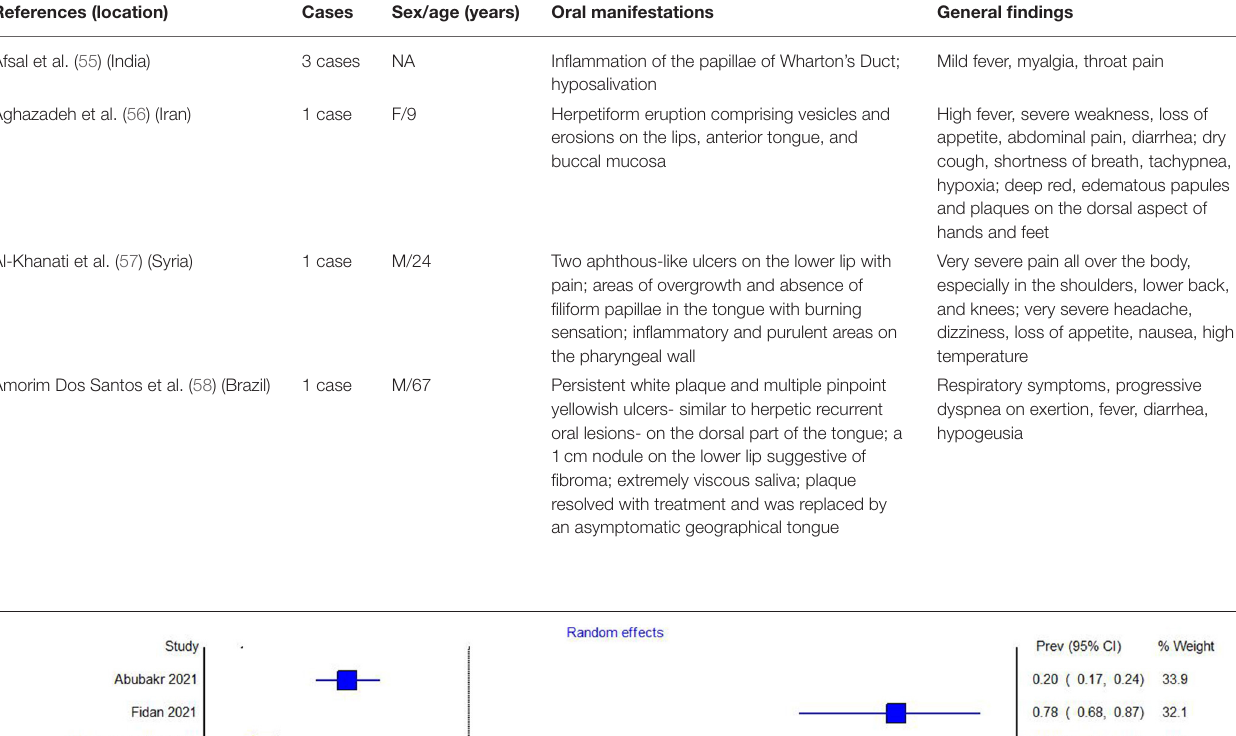
TABLE 3 | Characteristics of oral manifestations reported in case reports and case series.